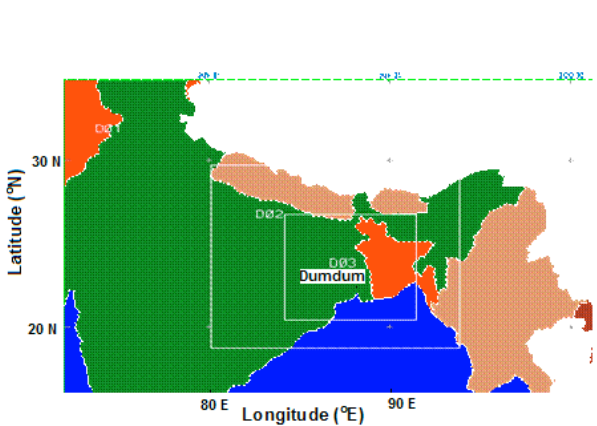
Fig. 1. Model domains with the innermost one being the domain of